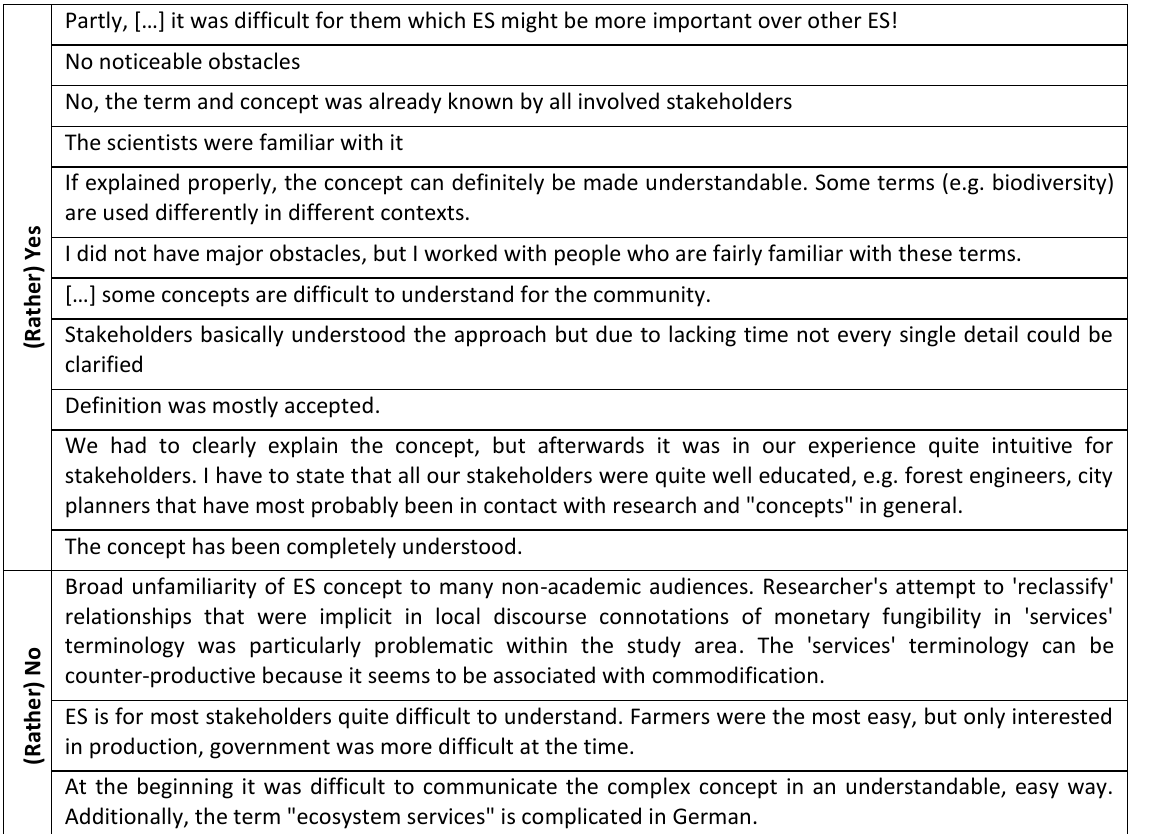
Table A1: Extended optional answers to the question whether the concept was accepted and understood by stakeholders (question 15.1 in the questionnaire)